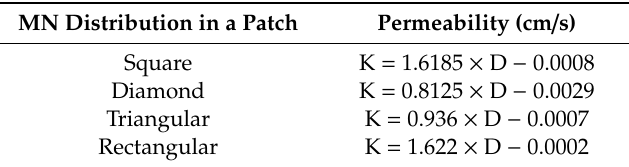
Table 1. Correlations of permeability (K) of drug molecules for di ff erent patterns of MNs patch. K is related to the di ff usion coe ffi cient (D) as discussed by Al-Qallaf and Das [111]. MN Distribution in a Patch Permeability (cm / s)